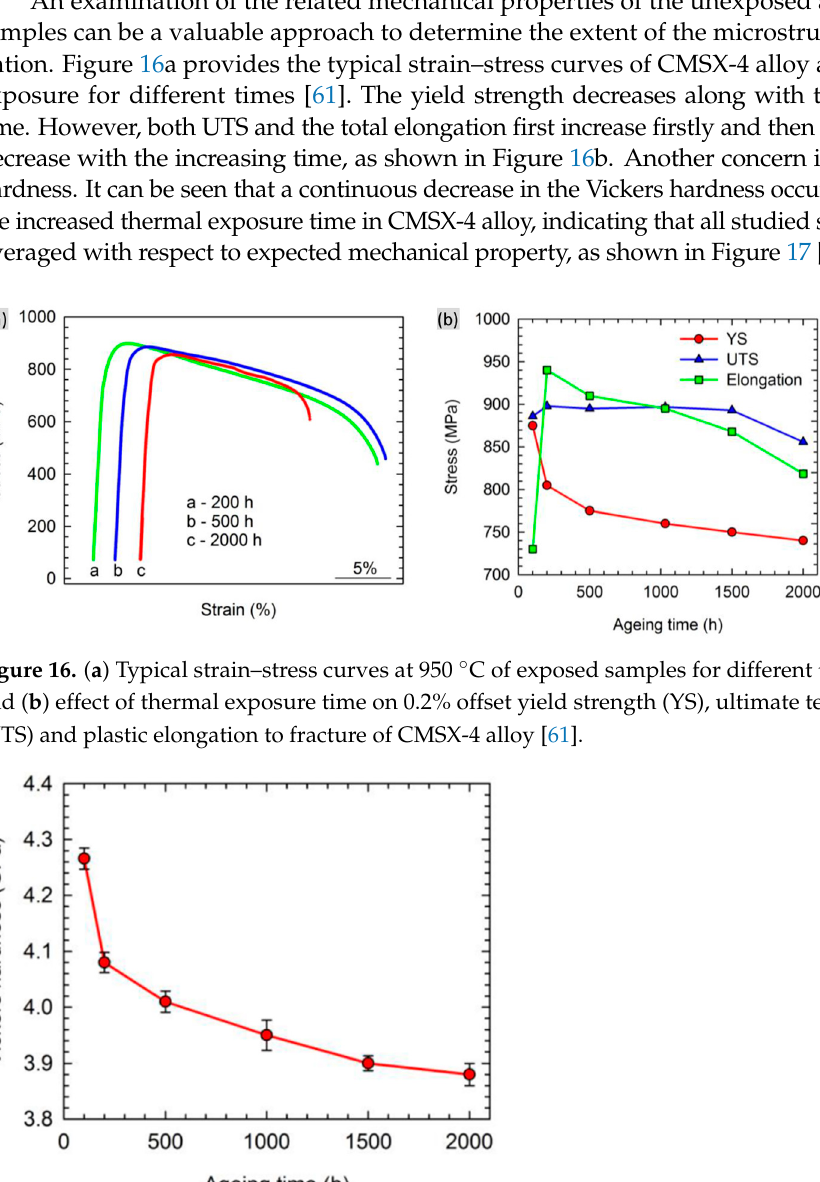
Figure 15. Area fraction of TCP phases of alloys with different alloying elements contents after ther- mal exposure at 1000 °C for 1000 h [60].